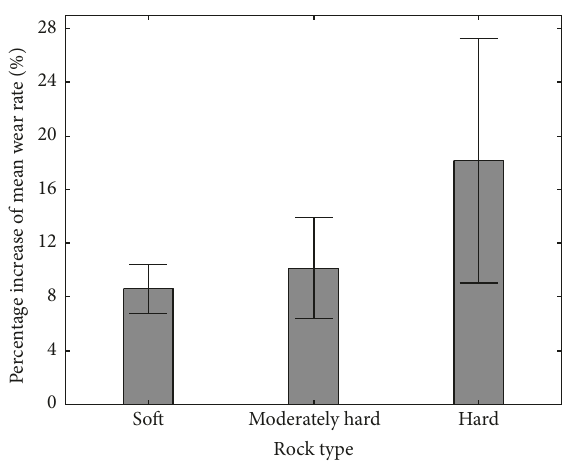
Figure 10: Percentage increases of mean cutter wear rate caused by